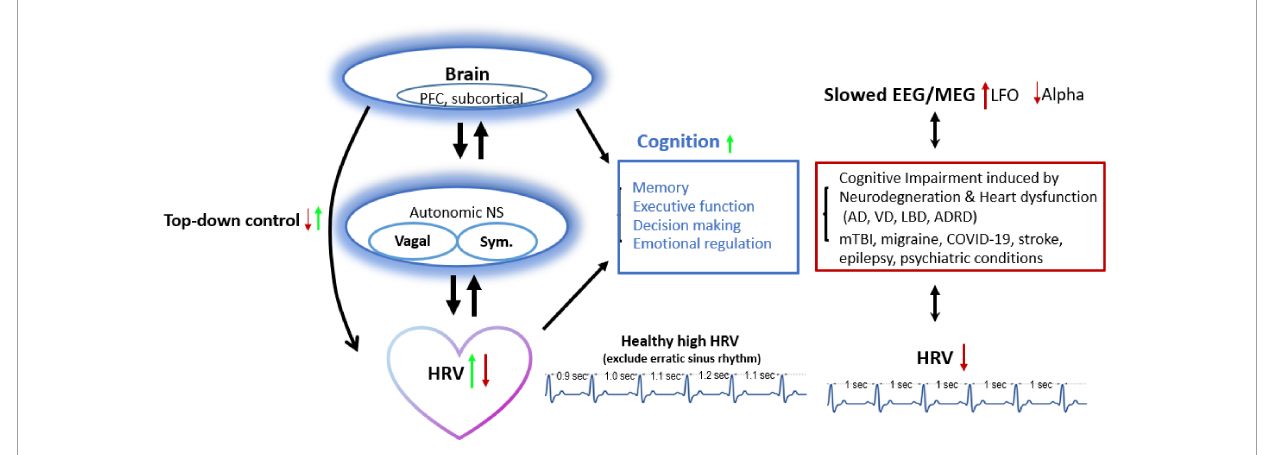
FIGURE3 HRV and brain cognition have bidirectional connections: Decreased HRV (from lower top-down inhibitory control) links with reduced executive function, decision making, or emotional regulation and presents in pathological conditions (dementia, mTBI, migraine, etc.). Approach increasing HRV also improves brain activity (e.g., alpha frequency oscillation ranged 8–12 Hz) and top-down control, and vice versa. AD, Alzheimer’s disease; ADRD, Alzheimer’s disease and related dementia; HRV, heart rate variability; LBD, Lewy body dementia; LFO, Low frequency Oscillation; mTBI, mild traumatic brain injury; NS, nerval system; PFC, prefrontal cortex; RIPC, remote ischemic preconditioning; Sym., sympathetic activity; TMS, Transcranial magnetic stimulation; vagal, vagal activity; VD, vascular